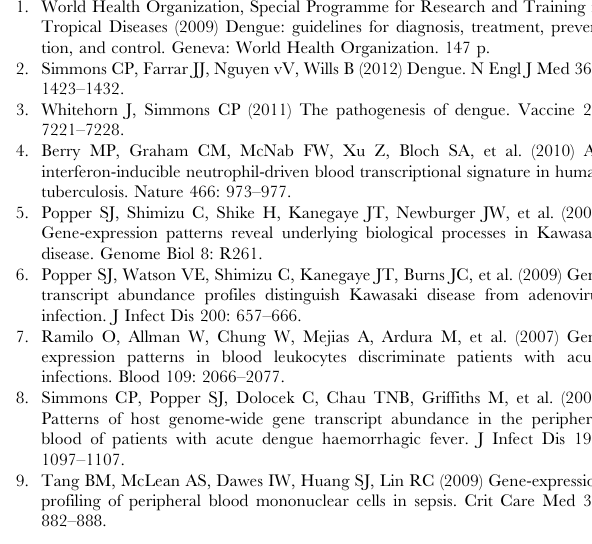
Figure S5 Comparison of gene expression profiles in response to viral infection. A dengue-response signature was constructed by calculating the median expression across all samples collected between fever day 3 and fever day 7 of genes with differential expression compared to healthy controls (Fig. 4). Studies including one or more comparisons of blood-based expression patterns in infected individuals and healthy controls were identified in Nextbio, and the associated list of differentially expressed genes was compared to the dengue-response signature from the current study. The length of the bar in each row indicates how similar each profile is to the profiles from the current study using the Nextbio measure of significance, which includes both the number of overlapping genes and the overall correlation of the patterns [31]. Table S1 Transcripts that are associated with differ- ences between primary DF and secondary DSS on fever day 3 (FDR ,